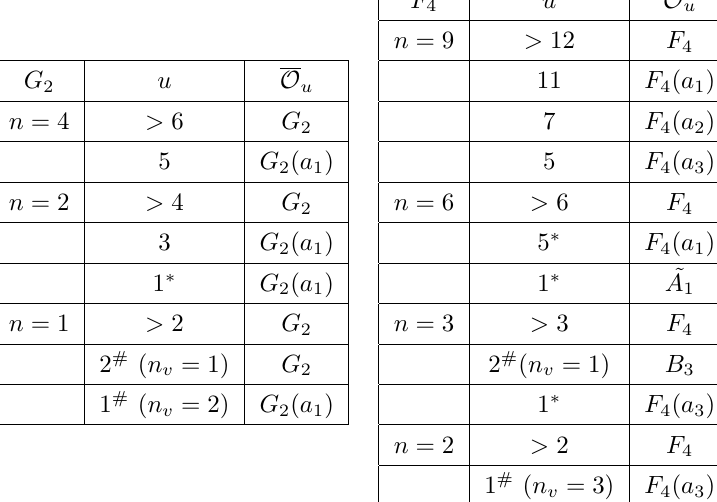
Table 19 . Associated variety for G 2 and F 4 type theory. The rank of Coulomb branch of G 2 type theory: r = 4 u − 1 . The rank of Coulomb branch of F 4 type theory: r = 18 u n # implies that the IR theory has free vector multiplets in the Higgs branch, and n of free vector multiplets. The one with ∗ means that the theory has pure Higgs branch, i.e. the IR theory on the Higgs branch consists of free hypermultiplets